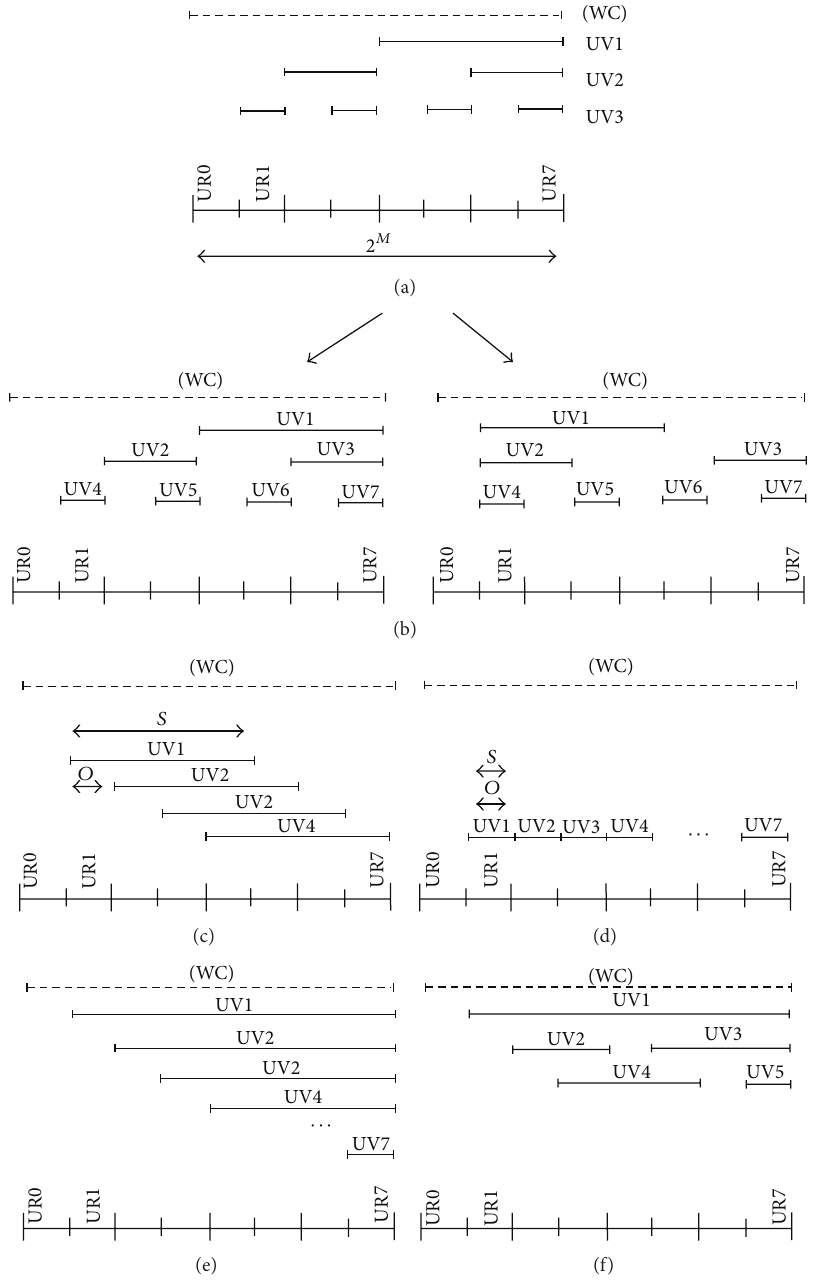
Figure 3: Worst overlappings: (a) theoretical worst-case number of overlappings ( | UR | = 2 | UV | ), (b) practical worst-case number of overlappings for PX-based rulesets ( | UR | = | UV | ), (c) practical worst-case for AR-based rulesets ( | UR | = 2| UV | − 1 ), (d) practical worst-case for EX-based (i.e., maximum-length PX) rulesets ( | UR | = | UV | ), and (e) and (f) practical worst-cases for GR-based rulesets ( | UV | ≤ | UR | ≤ 2| UV | − 1